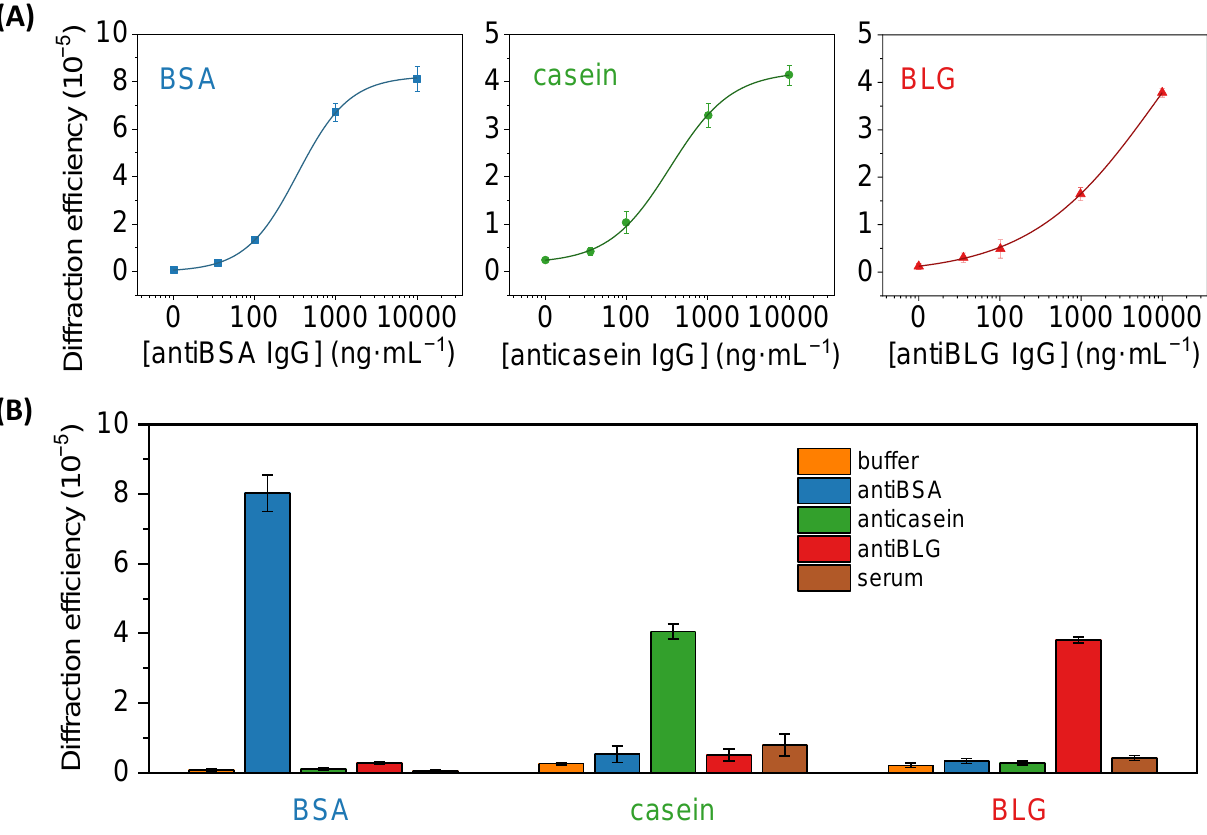
Figure 7. ( A ) Dose-response immunoassay curves obtained with diffractive patterns of BSA, casein, and BLG, after the incubation of a range of concentrations of specific IgG solutions (antiBSA, anticasein, and antiBLG, respectively). Experimental data were fitted to a sigmoidal regression (4-parameter logistic, R 2 = 0.999 in all cases). See Figure S9 for a zoomed view of the graphs in their low-concentration range. ( B ) Diffraction efficiencies achieved in BSA, casein, and BLG patterns after incubating PBST (buffer), 10 µg·mL −1 of specific antiBSA, anticasein and antiBLG antibodies in buffer, and human serum. Table 1. Limits of detection and quantification calculated from the experimental trends.